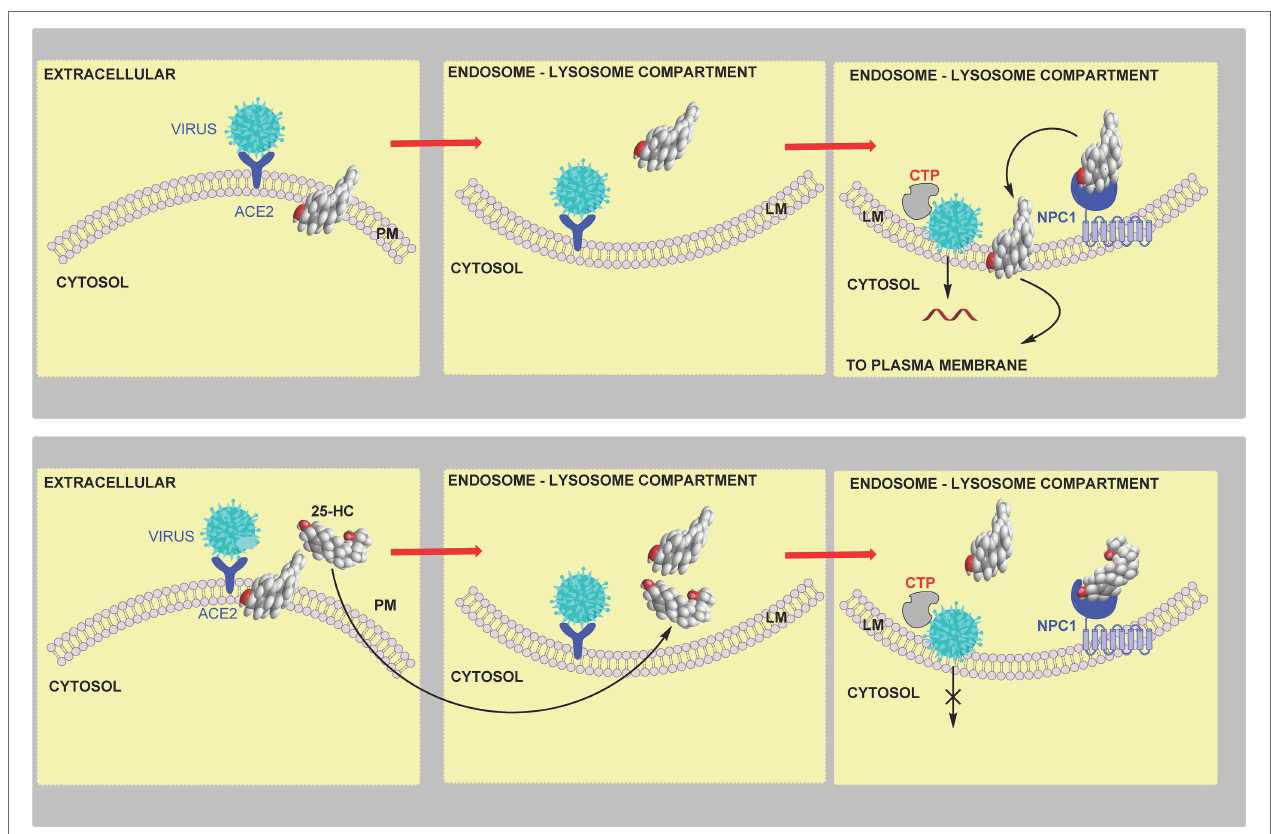
FIGURE 13 | Model of coronavirus entry via the late endocytosis pathway. Upper panel , in the absence of TMPRSS2, virus is endocytosed and within the endosome-lysosome compartment low pH activates cathepsin (CTP) mediated cleavage of the spike protein triggering membrane fusion and release of viral RNA. Lower panel , 25-HC inhibits viral replication by binding to NPC1 and restricting cholesterol transport to the lysosome membrane and export, ultimately preventing membrane fusion and release of viral